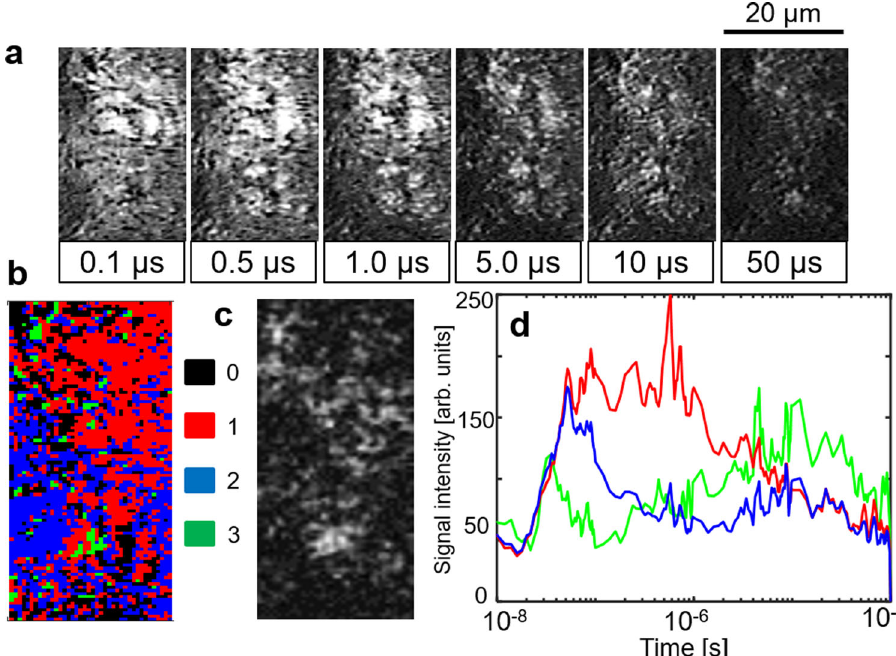
Fig. 4 Image sequence and clustering analysis with mediator. a An image sequence of the refractive index change for SrTiO 3 :Rh/ITO/BiVO 4 :Mo (STOR/ ITO/BVOM) in acetonitrile (ACN) in a square region (20 × 50 μ m) corresponding to no. 1 in Fig. 1, bottom on the order from nanoseconds to microseconds. The scale bar corresponds to 20 µ m. b The categorized mapping of the charge carrier responses of a . An outlier positioned far from all categories was colored in black (#0). c A microscopic image in the same area as in a . d The averaged responses for each category in b are shown. (red: category 1, blue: category 2, green: category 3).